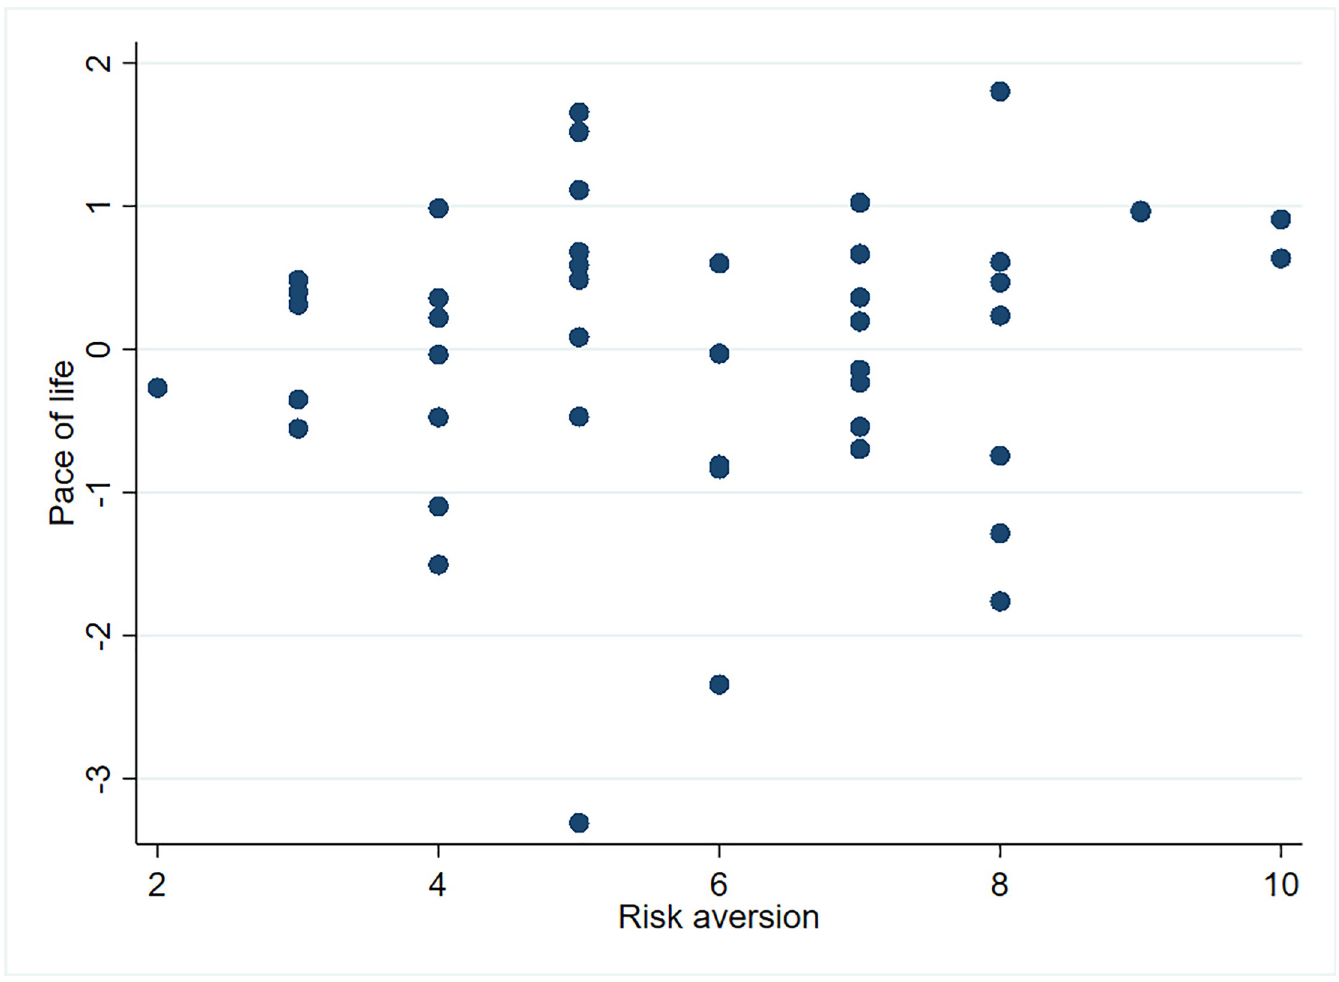
Fig 5. Pace of life and risk